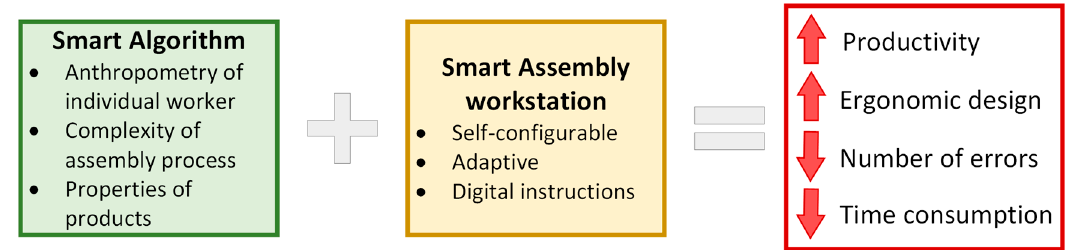
Figure 2. Smart algorithm and smart assembly workstation for improved productivity of the assembly process.